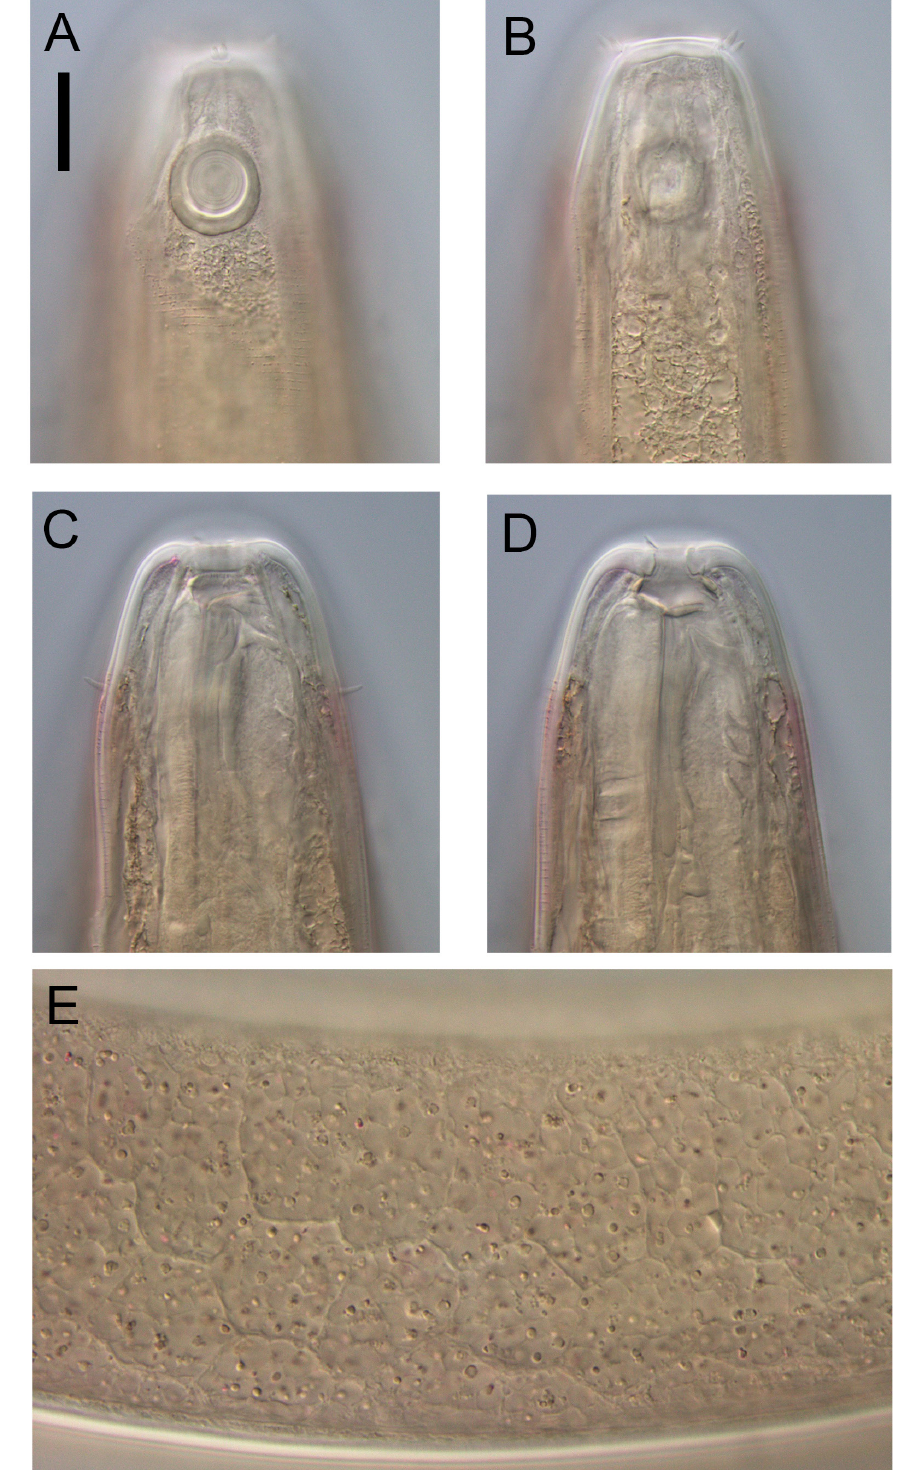
Fig. 6 . Linhomoeus pycnocricus sp. nov. Light micrographs of male, paratype (NIWA154907). A . Cephalic region showing amphid. B . Cephalic region showing cephalic sensilla. C . Cephalic region showing subcephalic sensilla. D . Cephalic region showing buccal cavity and pharynx. E . Intestine. Scale bar: A–D = 20 µm; E = 15